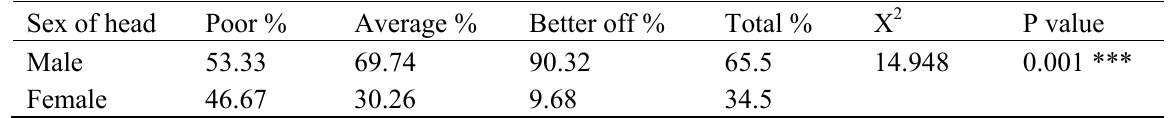
Table 4. Well-being status by gender of